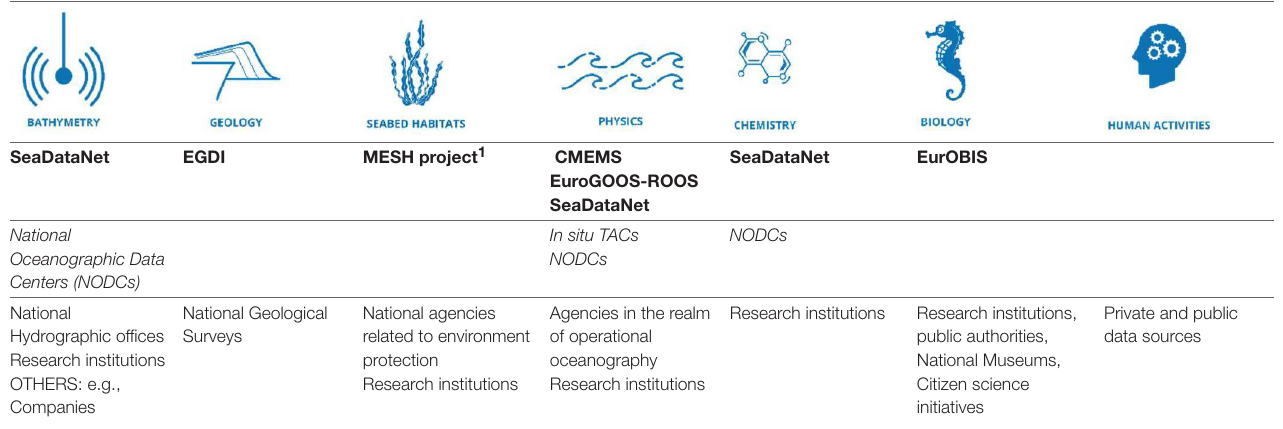
TABLE 3 | Main data initiatives (networks, projects, data management infrastructures…) data assembly centers (in italics) and data originators underpinning each of the EMODnet portals in